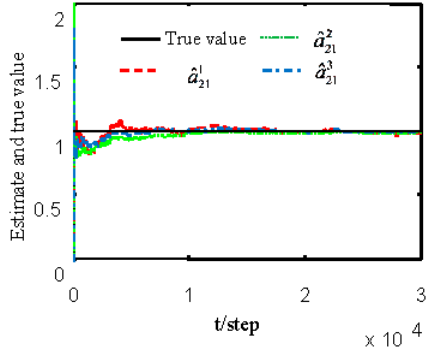
Figure 8. Local estimates of unknown parameter a 21